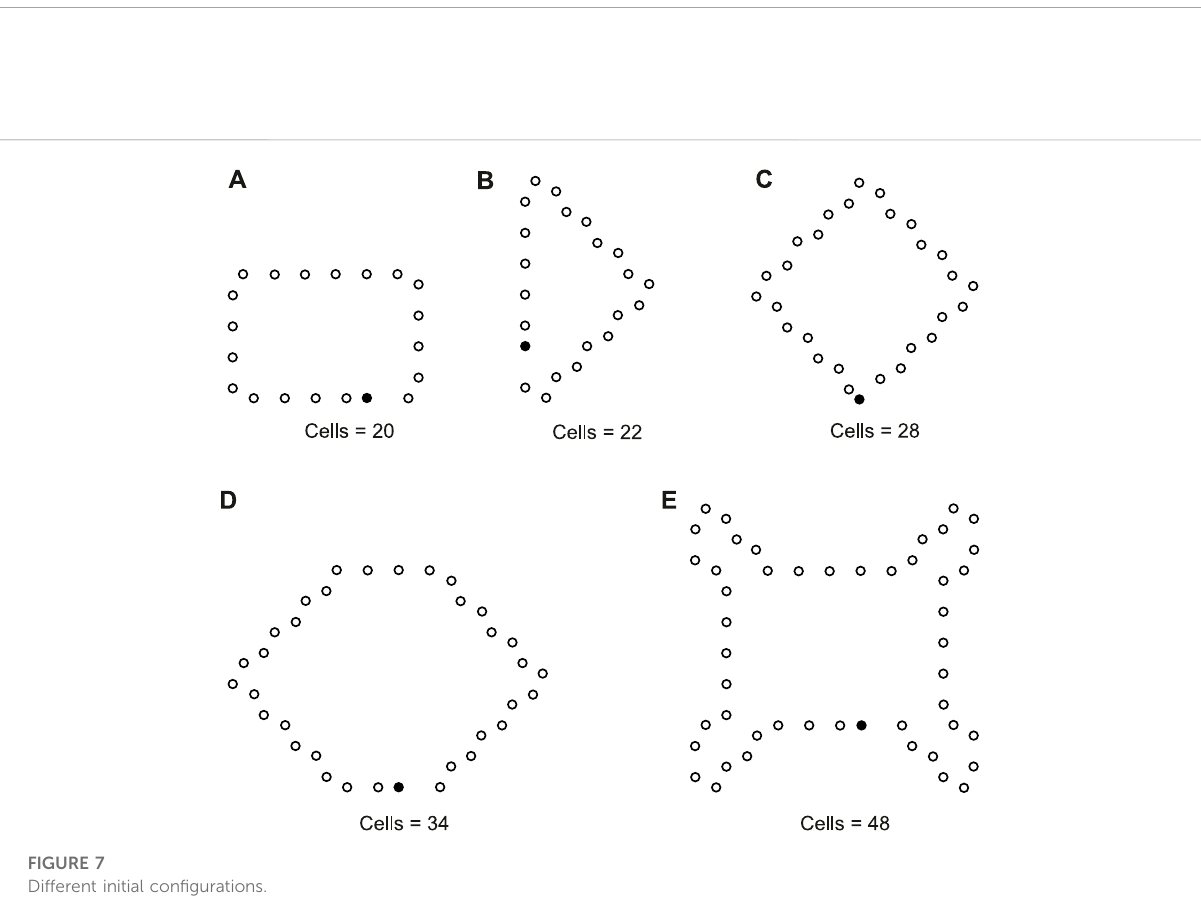
FIGURE 7 Different initial con fi